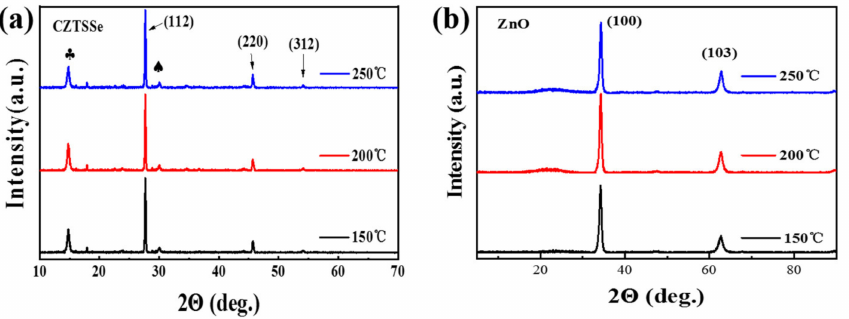
Figure 4. XRD patterns of ZnO/CZTSSe heterojunctions annealed at different temperatures: ( a ) conven- tional XRD and ( b ) GIXRD patterns. The peaks at 14.8 ◦ and 30.1 ◦ are marked ♣ and ♠ ,